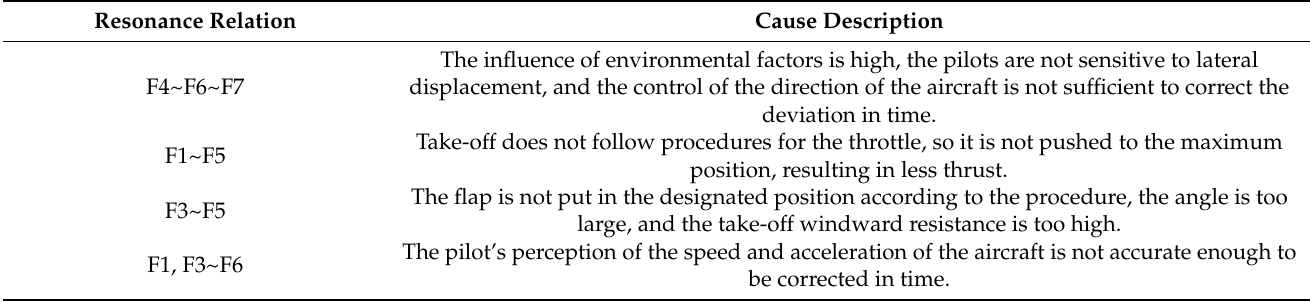
Table 13. Cause analysis of functional resonance.